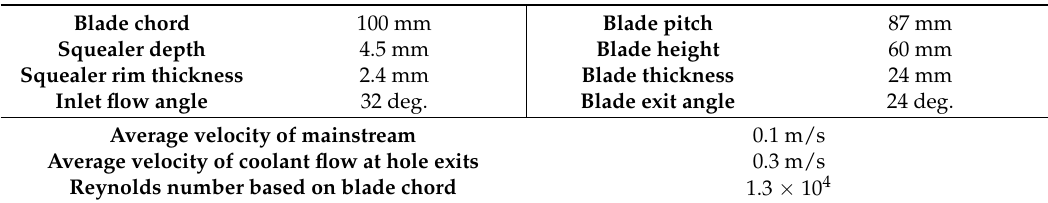
Table 1. Tested blade parameters (scaled up by three times) and experimental conditions. Blade chord